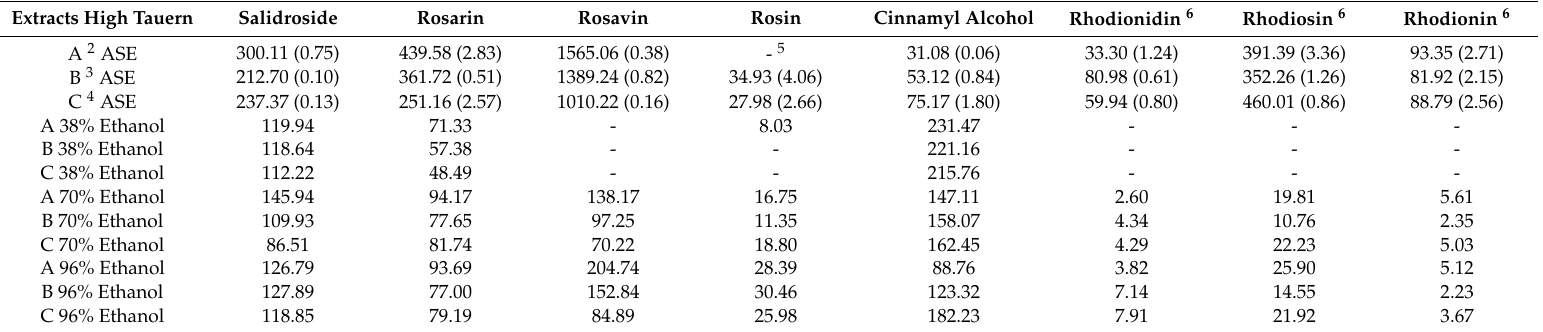
Table 5. Quantitative analysis of Rhodiola rosea rhizome extracts from collection site High Tauern (mg / 100 g plant material 1 ).